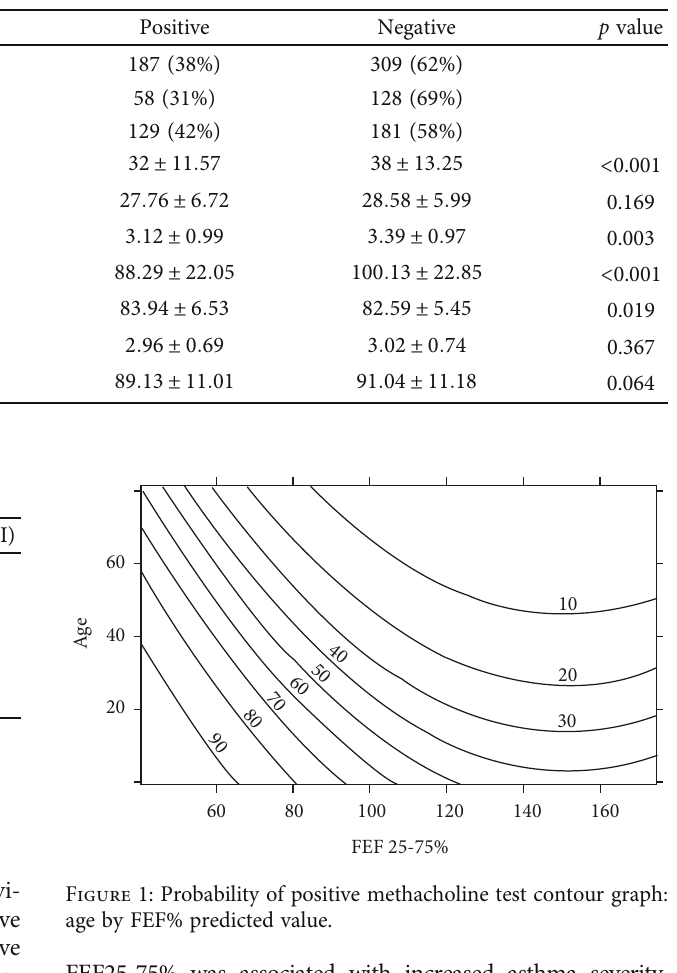
Table 1: Baseline characteristics and results.